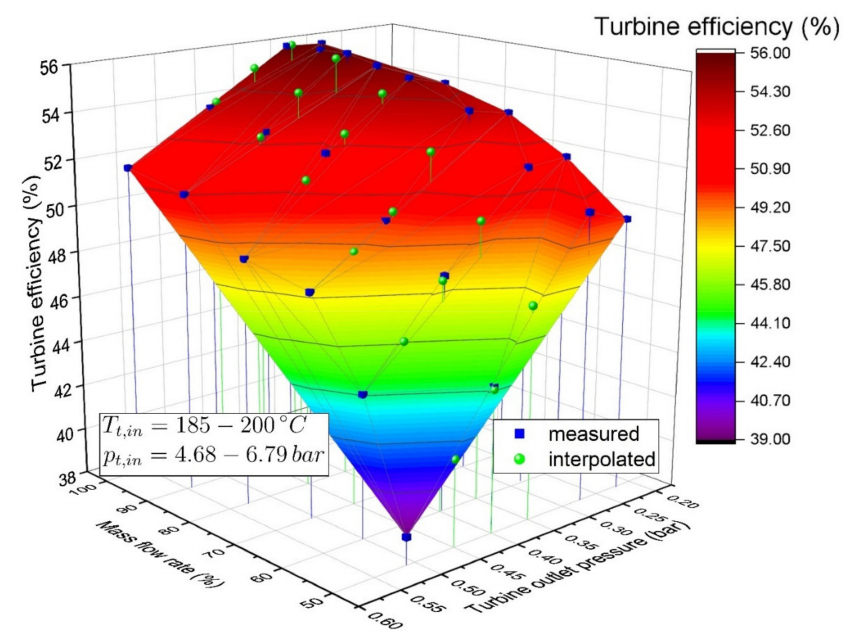
Figure 5. Turbine efficiency (measured and interpolated) of the A-ANH configuration in dependency on the mass flow rate and turbine outlet pressure.